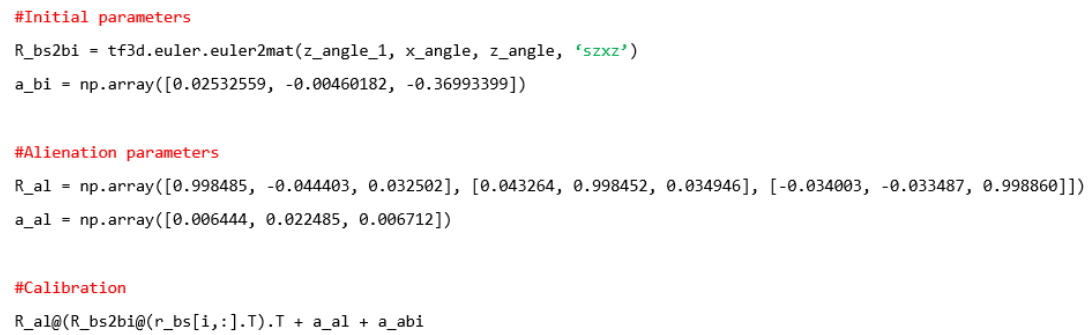
Figure 11. Parameters and calibration equation.